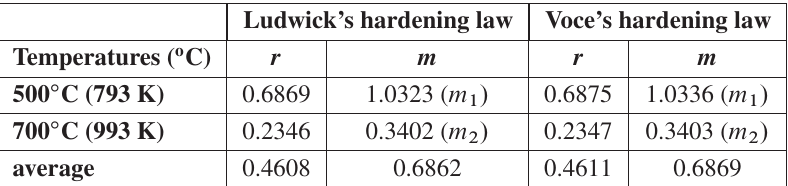
Table 3. Results of r and m values’ calculation.